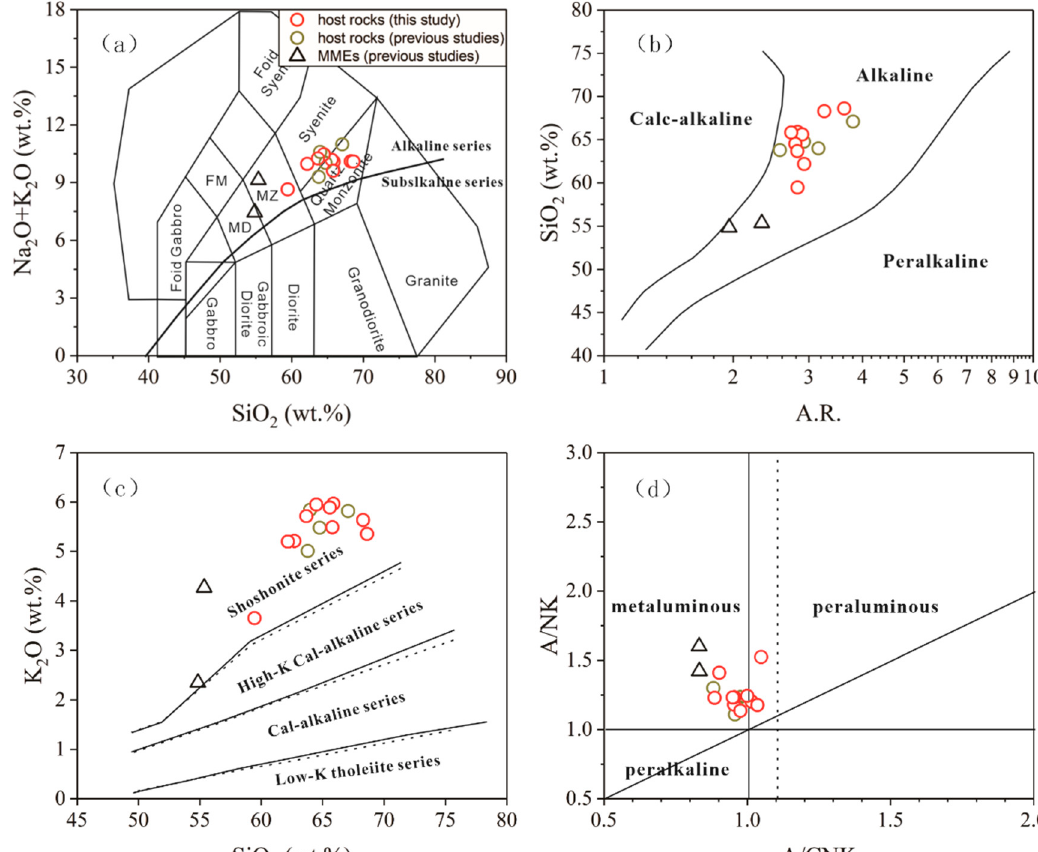
Figure 7. Chemical classification of rocks from the Muchen rocks. ( a ) Total alkali vs. silica (TAS) diagram [65]; with the thick solid line from Irvine and Baragar; [66]); ( b ) SiO 2 vs. alkalinity ratio (A.R.) diagram [67]; ( c ) K 2 O vs. SiO 2 diagram (solid lines from [68]; dashed lines from [69]); ( d ) A / NK vs. A / CNK diagram [70,71]; Previous data of Muchen rocks from Liu et al. [30]. A / CNK = Al 2 O 3 / (CaO + Na 2 O + K 2 O) (with molar ratio), A/NK = Al 2 O 3 /(Na 2 O + K 2 O) (with molar ratio).